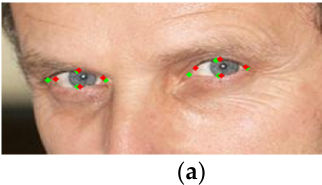
Sensors 2016 , 16 , 1105 20 of 24 Figure 22. Difference between the annotated eye corners and the detected sclera landmarks. It can be noticed that even if the sclera is correctly segmented, there is a larger distance between the annotated eye corners and the sclera landmarks. ( a ) Annotated landmarks on LFPW database (in green) and detected sclera landmarks (in red); and ( b ) segmented sclera region.